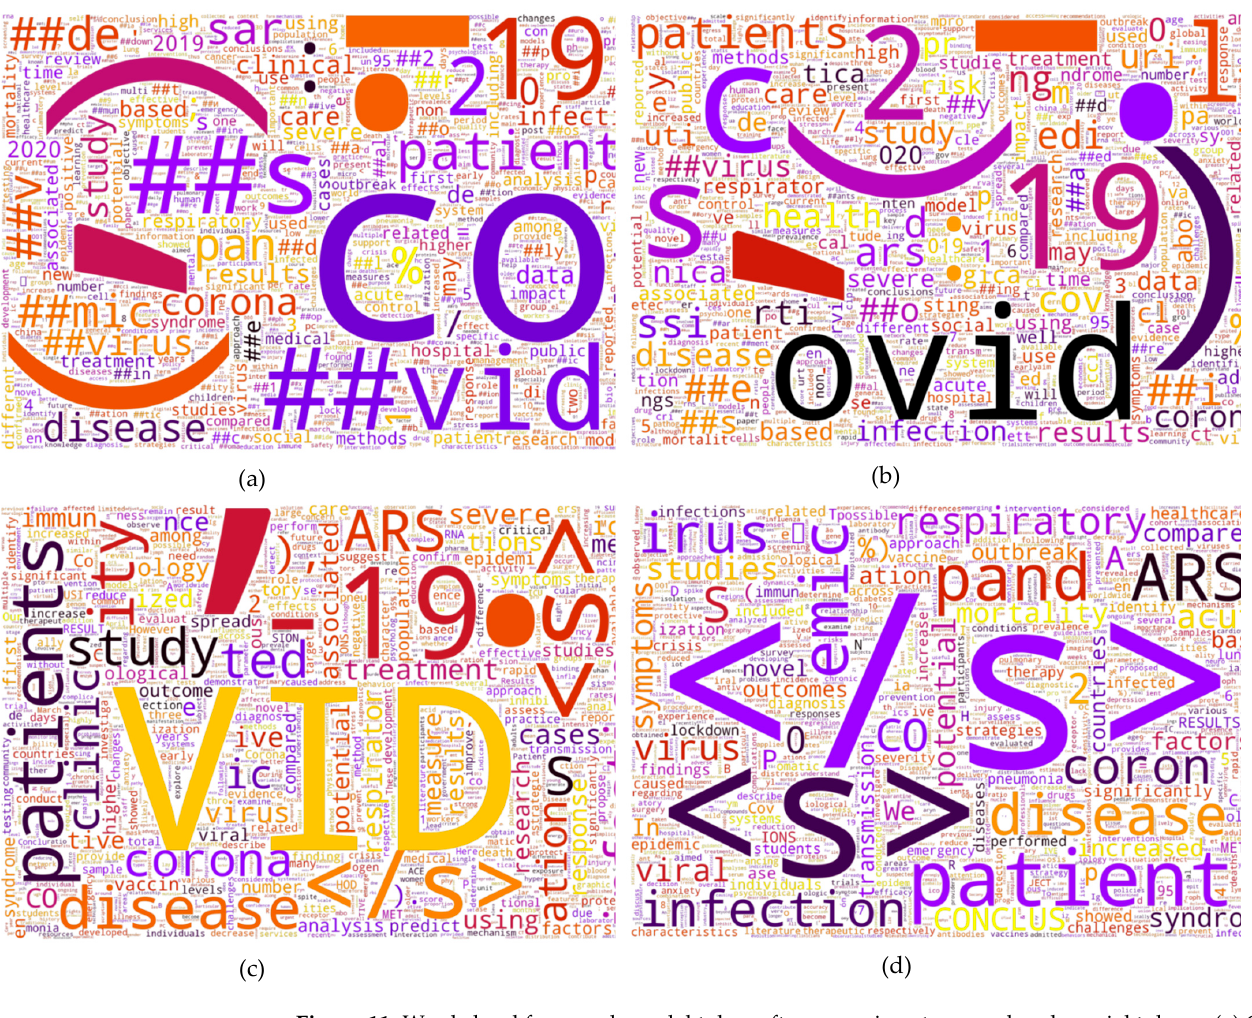
Figure 11. Word cloud from each model token after removing stop word and special tokens: ( a ) CT- bert V2 token, ( b ) Our model token, ( c ) xlm-robera-large token, ( d ) bart-large token .